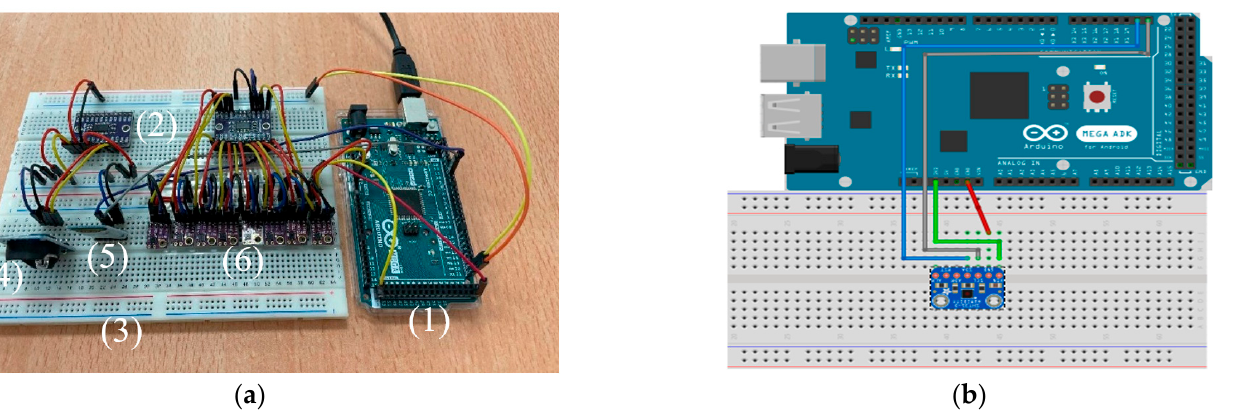
Figure 6. Outdoor module of HEAT ( a ) and wire connections of one SHT35 sensor with the Arduino Mega ( b ).